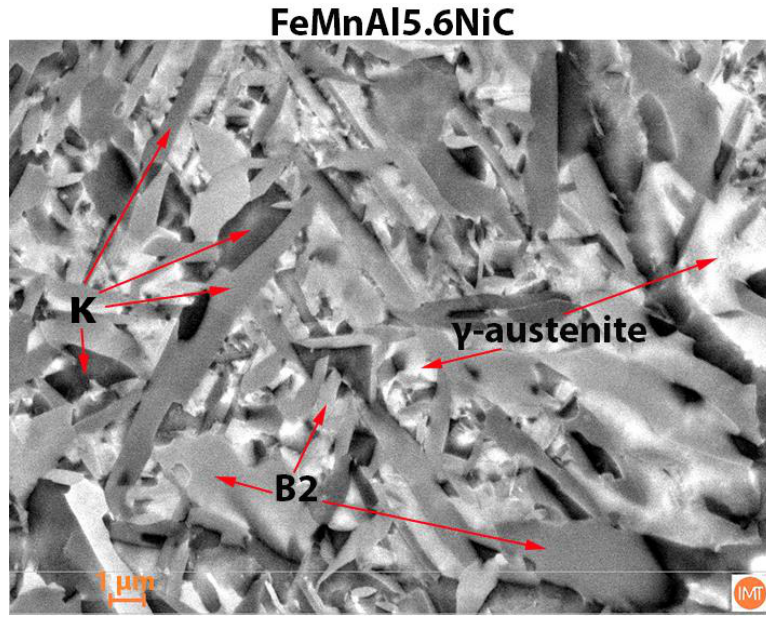
Figure 10. The decomposed austenite consists of kappa carbides, B2 ordered phase and γ -austenite. The sample with the highest Ni content (8.6 wt.%) has a simple duplex microstructure, the γ -austenite did not decompose. The increased Ni content was expected to increase the decomposition rate of austenite, as observed in the sample with 5.6% Ni, but it did not. The CALPHAD calculations show that the amount of B2 ordered phase is, in fact, severely lowered at 8.6 wt.% Ni. The secondary B2 ordered phase peak during cooling, which is attributed to the austenite decomposition, is much lower than the other compositions. The start temperature of kappa carbide formation is also the lowest and attributed to the absence of kappa carbides. It is interesting to note that Ni is mainly present in the α -ferrite, although it is a gamma-forming element. The SEM EDS mapping results confirm the Thermo-Calc calculations, as can be seen in Figure 11.